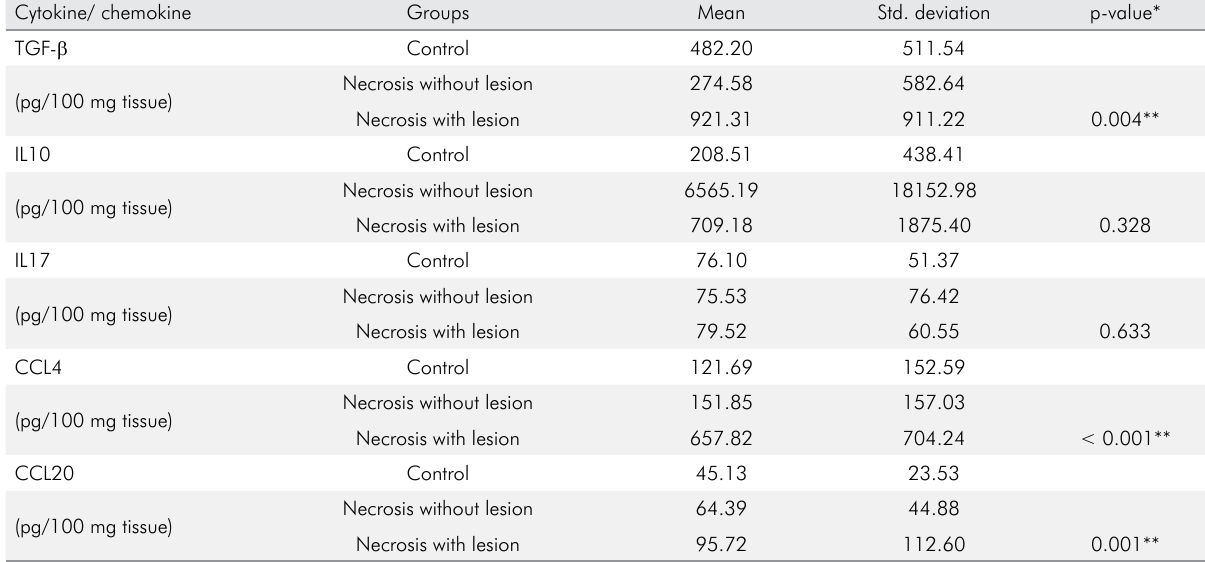
Table 1. Descriptive analysis and comparison of the cytokine and chemokine levels among groups. Cytokine/ chemokine